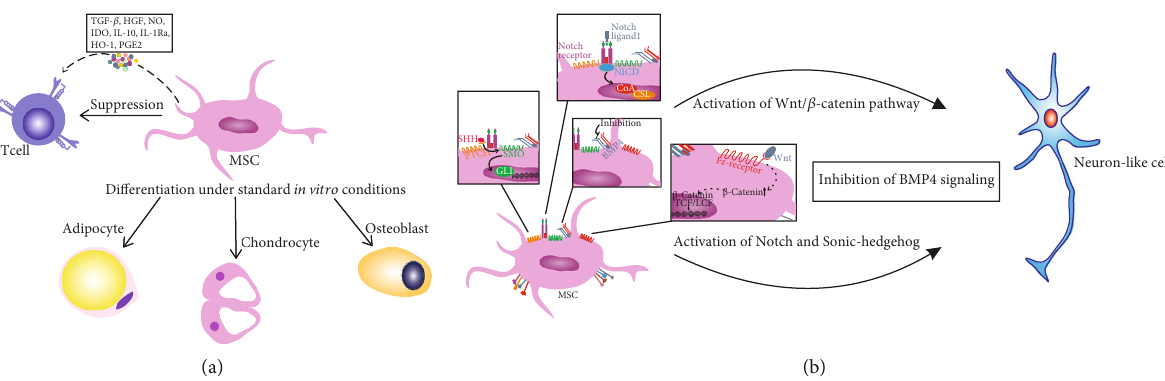
Figure 1: Functional properties of MSCs. MSCs are able to suppress e ff ector T cells in a juxtacrine manner (through the program death (PD) ligand: PD receptor interaction) or in a paracrine manner, via the production of soluble immunoregulatory factors (transforming growth factor- β (TGF- β ), HGF, nitric oxide (NO), indoleamine 2,3-dioxygenase (IDO), interleukin 10 (IL-10), interleukin 1 receptor antagonist (IL-1Ra), heme oxygenase- (HO-) 1, and prostaglandin E2 (PGE2)), and di ff erentiate into adipocytes, osteoblasts, and chondrocytes under standard culture conditions (a). Activation of Wnt/ β -catenin, Notch, and Sonic-hedgehog pathways as well as inhibition of bone morphogenetic protein 4 (BMP4) signaling in MSCs promoted their di ff erentiation in neuron-like cells